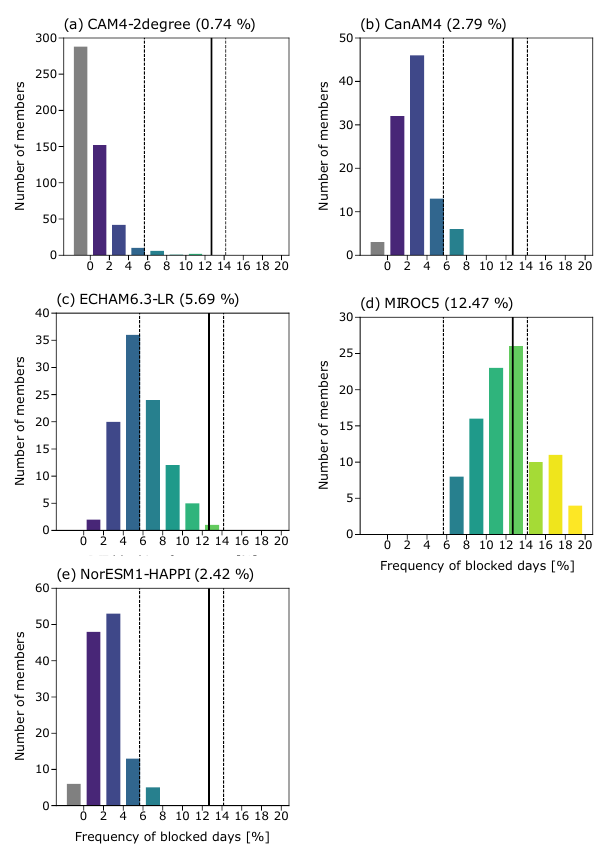
Figure 2. Distributions of the nine-winter (DJF) mean frequency of Greenland blocking days (in 2% bins) for each ensemble. The mean frequency of each model is shown in the title and given in Table 1. Shown in every panel is the mean frequency of Greenland blocking days from ERA-Interim for 2006–2015, which is 12.68% (black line), and the minimum and maximum frequencies of blocking days from nine consecutive winters for the whole ERA-Interim period of 1979–2018, which are 5.66% and 14.16%, respectively (dashed lines). Grey bars show the number of members with no GB in the 9-year